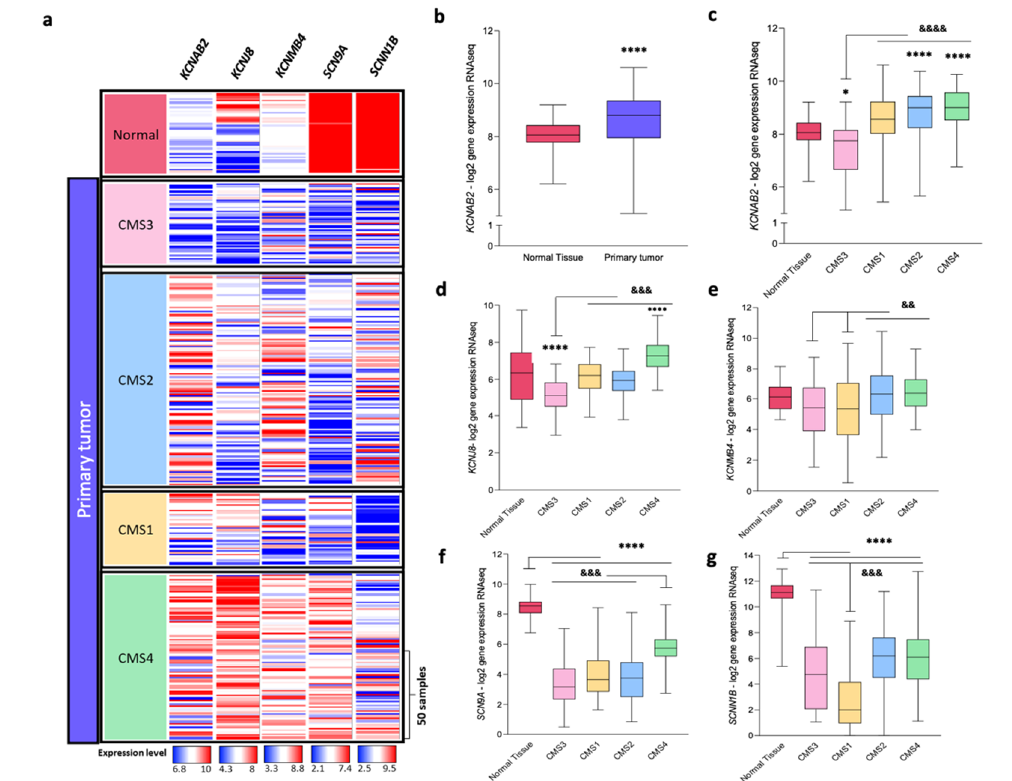
Figure 9. Consensus molecular subtype (CMS) association of gene expression level of potential targets. ( a ) Expression level heat-map of selected genes in primary tumors and solid tissue normal samples, and CMS-sample association [36]. Data were visualized with Xena Browser (USCS) using the TCGA COADREAD database (RNAseq–Illumina HiSeq, n = 431). ( b ) KCNAB2 gene expression in normal and primary tumor tissue. Statistical significance was assessed using an unpaired t -test with Welch’s correction, **** p < 0.0001. ( c – g ) Expression levels of genes coding for KCNAB2, KCNJ8 , KCNMB4, SCN9A, and SCNN1B, classified according to the CMS subtype. Statistical significance was assessed using one-way ANOVA. * indicates differences between healthy and the CMS subtypes, while indicates statistical differences among the CMS subtypes to the marked CMS. * p < 0.05, && p < 0.005, &&& p < 0.001, **** /&&&& p <